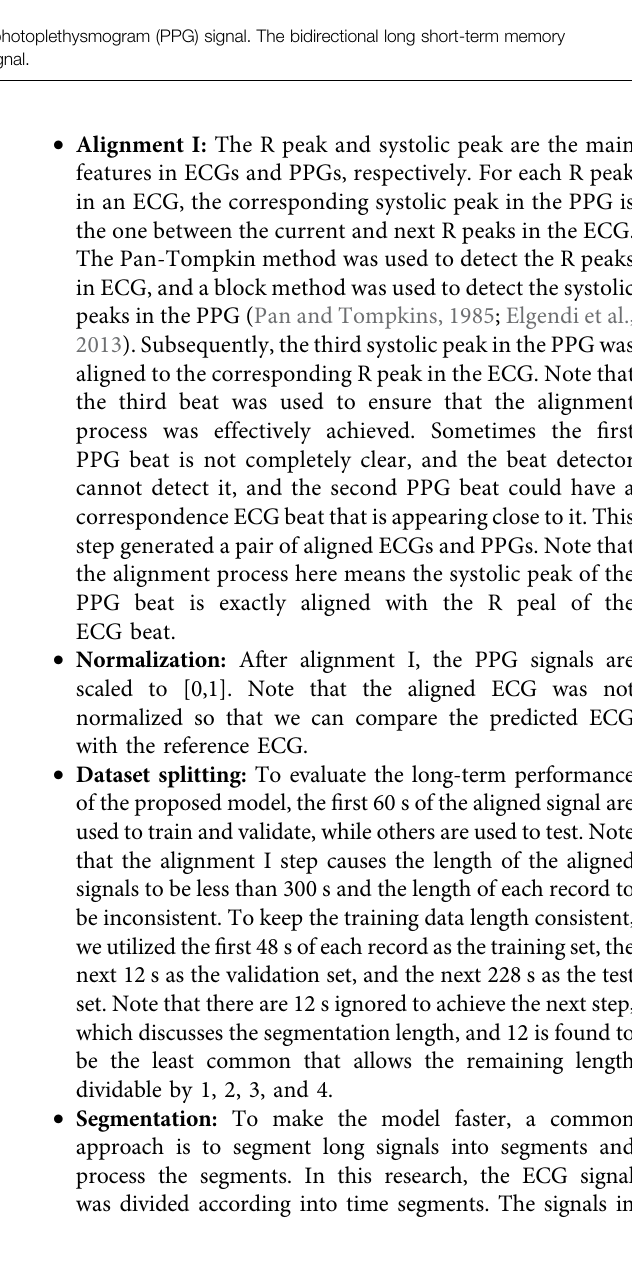
Frontiers in Physiology |